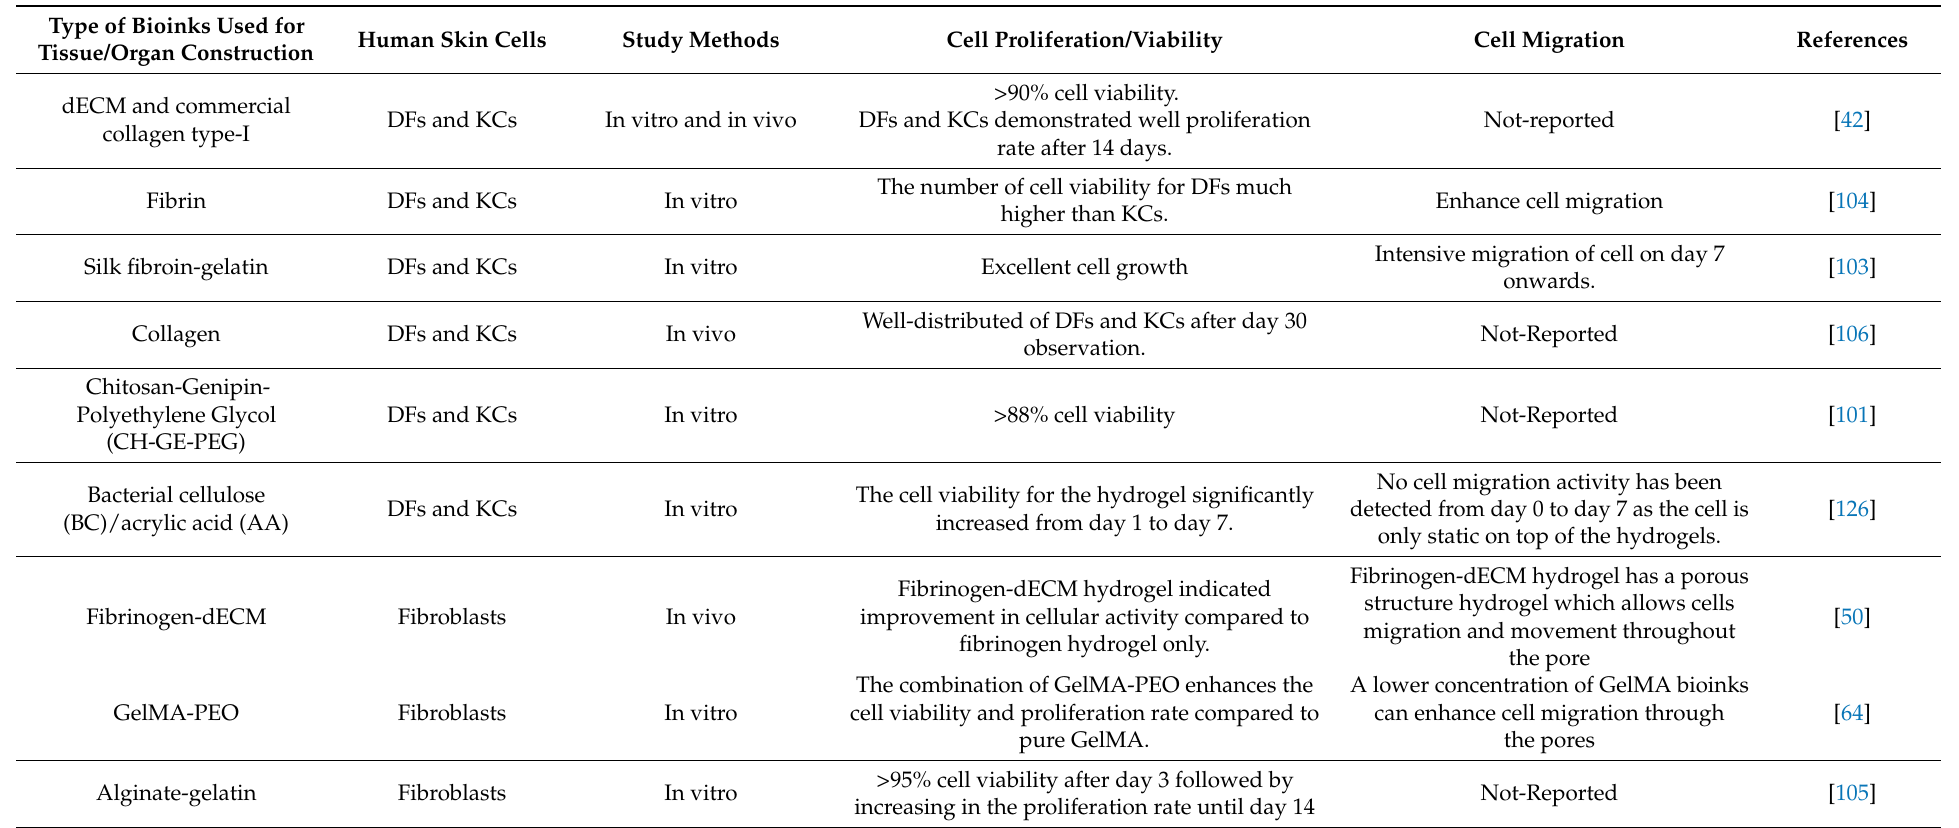
Table 2. Effect of cellular activity study of skin cells towards different type of